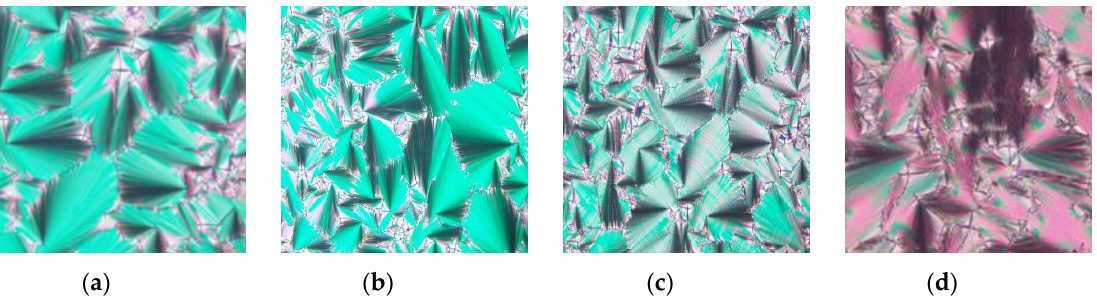
Figure 4. Optical textures observed by polarized optical microscopy (POM) during the cooling process: ( a ) 5-BPTMS at 111 °C (smectic A; SmeA), ( b ) 5-BPTMS at 96 °C (higher-order smectic; SmeX), ( c ) 5-BPTMS at 87 °C (crystalline; Cry′), and ( d ) 6-BPTMS at 103 °C (SmeA).